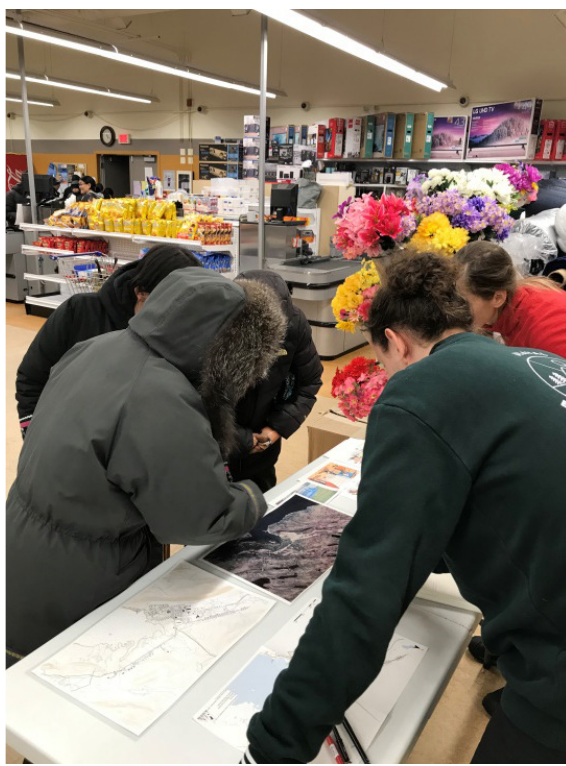
Figure 5. Informal discussions with Inuit residents at the Coop Store in Kangiqsualujjuaq, February 2020. Source: Trottier et al.